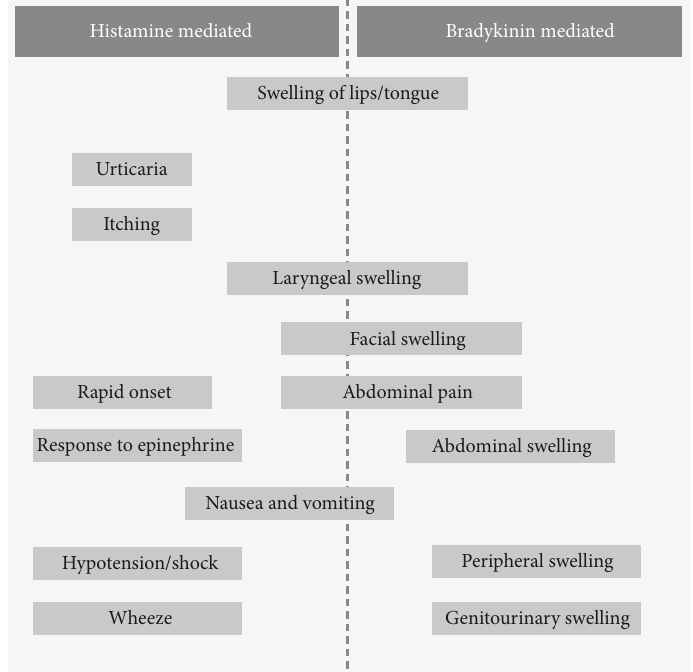
Figure 1: Distinguishing histamine-mediated versus bradykinin-mediated angioedema clinically (figure reproduced from Bernstein JA et al. (2017), [under the Creative Commons Attribution License/public domain]).